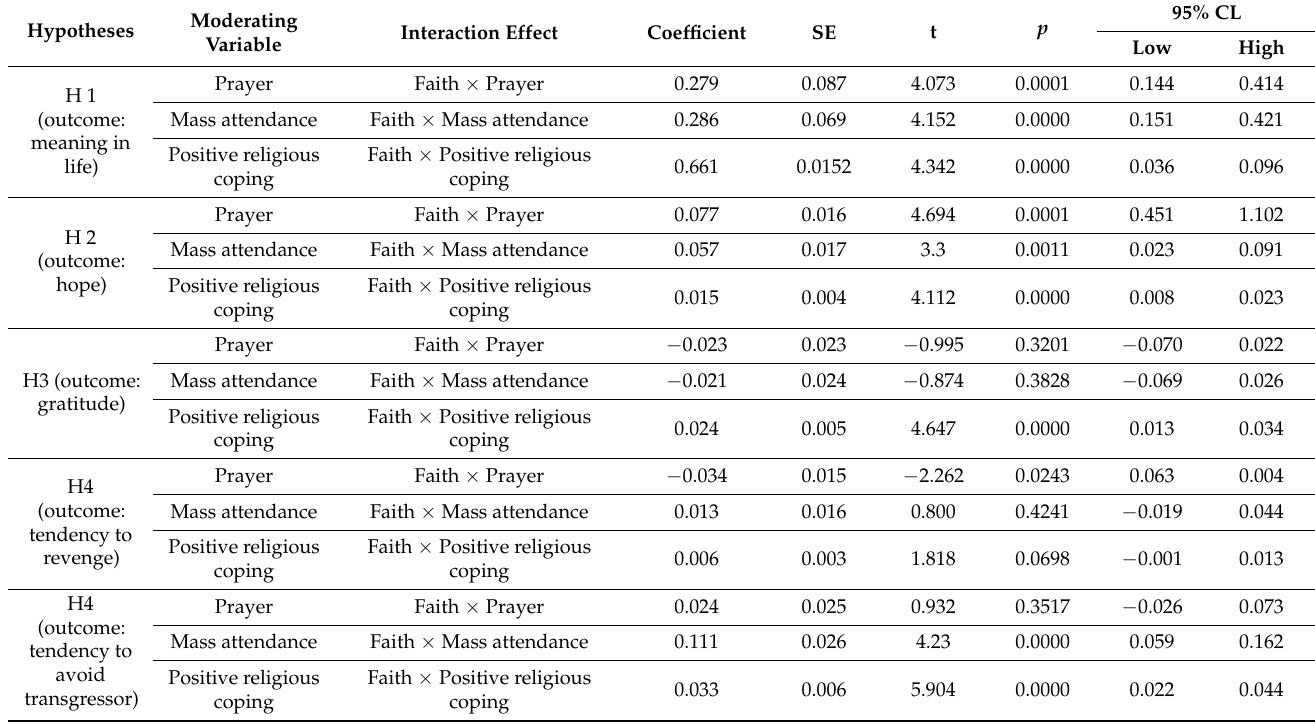
Table 3. Results of moderation